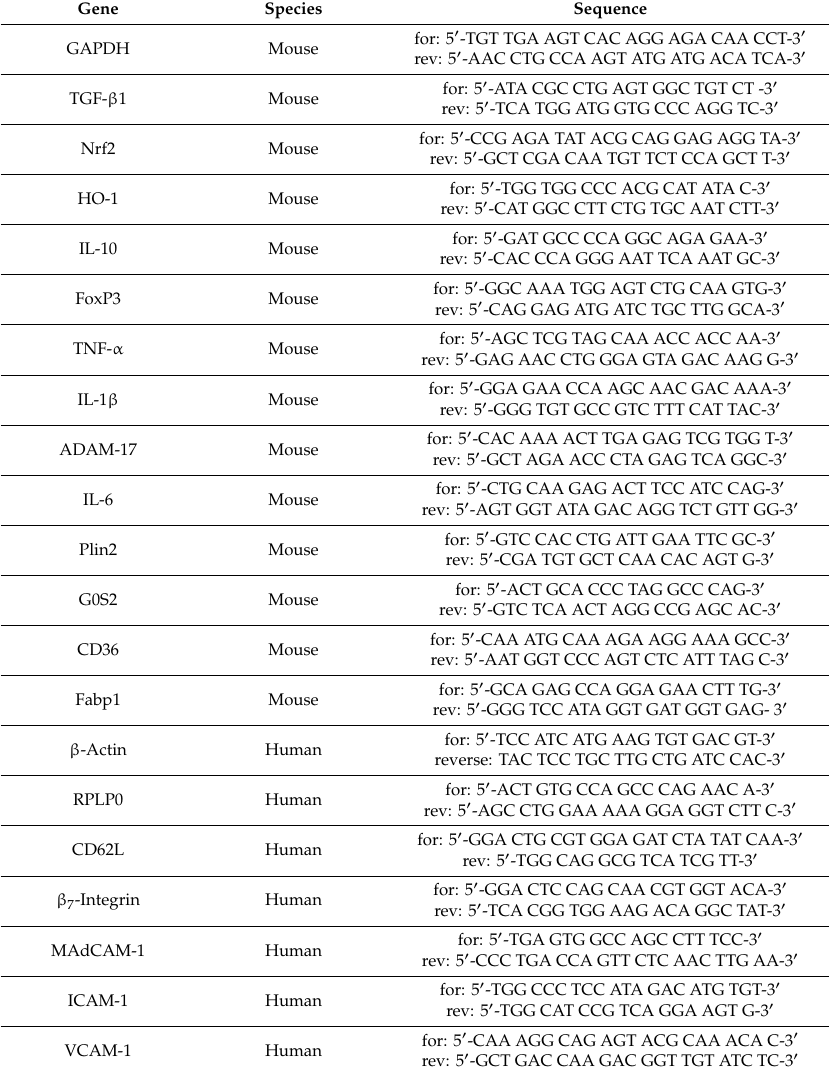
Abbreviations used: ADAM-17, a disintegrin and metalloproteinase domain 17; CD36, cluster of di ff erentiation 36; CD62L, Selectin L; Fabp1, fatty acid-binding protein 1; for, forward primer; FoxP3, Forkhead box P3; GAPDH, Glyceraldehyde 3-phosphate dehydrogenase; G0S2, Go(G1 switch gene 2; HO-1, heme oxygenase 1; ICAM-1, intercellular adhesion molecule 1; IL-1 β , interleukin-1 β ; IL-10, interleukin-10; IL-6, interleukin-6; MAdCAM-1, Mucosal vascular addressin cell adhesion molecule; Nrf2, NEF2-related factor 2; Plin2, Perlipin 2; rev, reverse primer, RPLP0, ribosomal phosphoprotein large P0; TGF- β 1, transforming growth factor- β 1; TNF- α , tumour necrosis factor- α ; VCAM-1, vascular cell adhesion protein